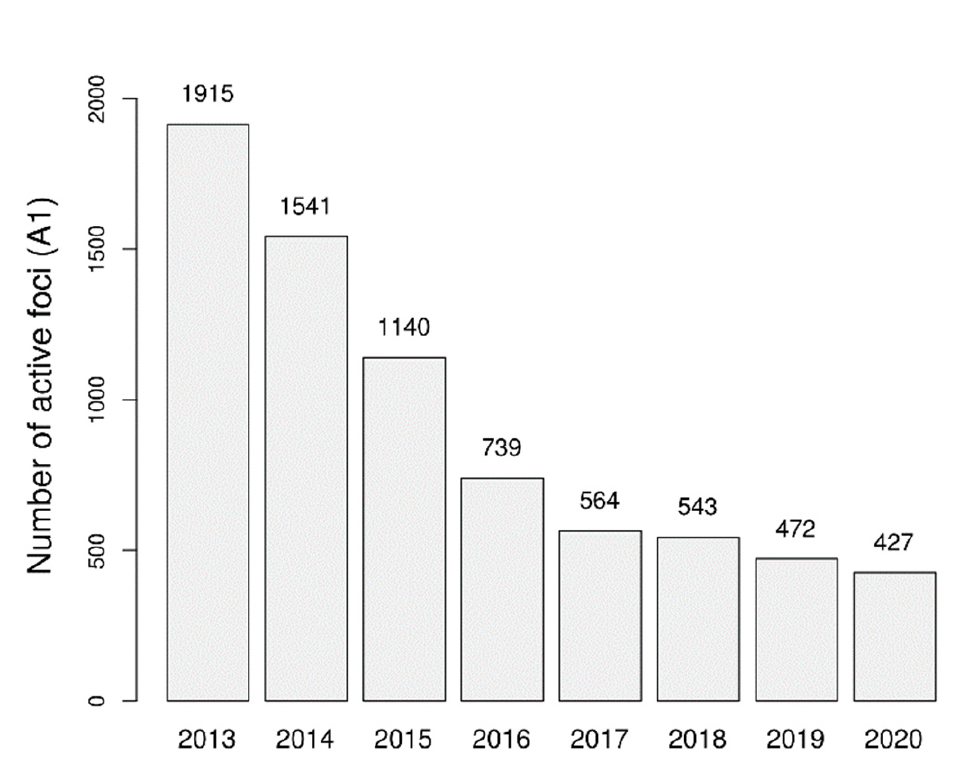
Figure 1. Number of reported active foci from FY2013 to FY2020. Reported A1 and A2 foci were highly concentrated along international borders, partic- ularly Thailand’s western border with Myanmar (Figure 2). Many active foci throughout Thailand gained A2 status during the study period, most notably near the eastern border with Lao PDR (Sakhon Nakhon, Mukdahan, and Ubon Ratchathani provinces) and the northeastern border with Myanmar (Chiang Mai and Mae Hong Son provinces). How- ever, persistent A1 foci (those that retained active foci status consistently for 5 years, from FY2016–FY2020) were almost exclusively found immediately adjacent to borders, showing increasing concentration from A2 to A1 to persistent A1 status (Figure 2).